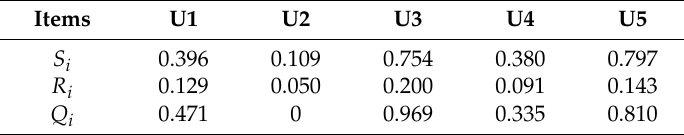
Table 22. Calculation results of S i , R i and Q i .